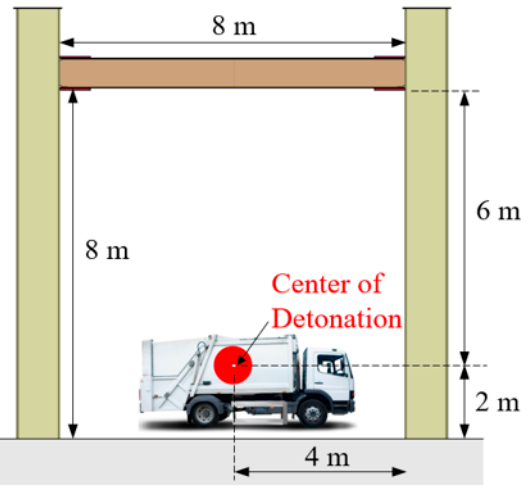
Figure 3. Blast scenario for evaluation of plate-reinforced large CFT connection subjected to detonation.